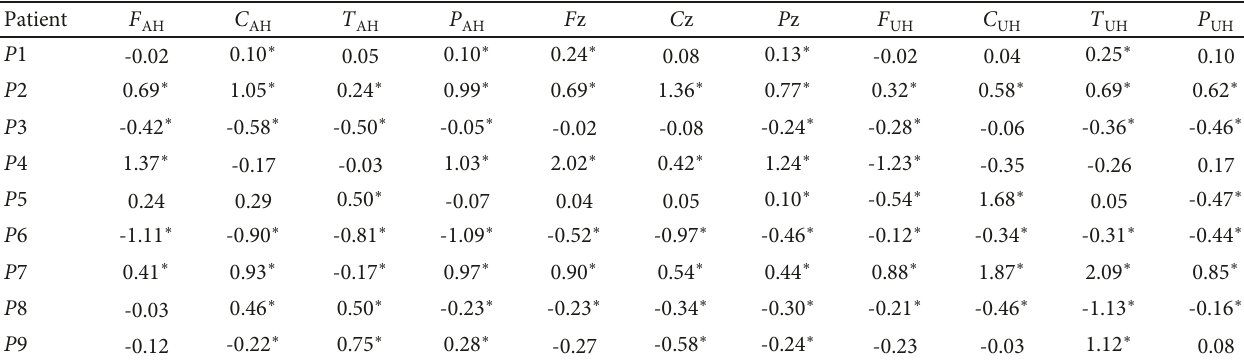
Table 4: Slopes of ERD/ERS computed for each patient in the beta band and for each AH ( F and UH ( F UH , C UH , T UH , and P UH ) channels. Slopes computed from ERD/ERS with a signi fi cant correlation with time since stroke onset ( ∗ ) are